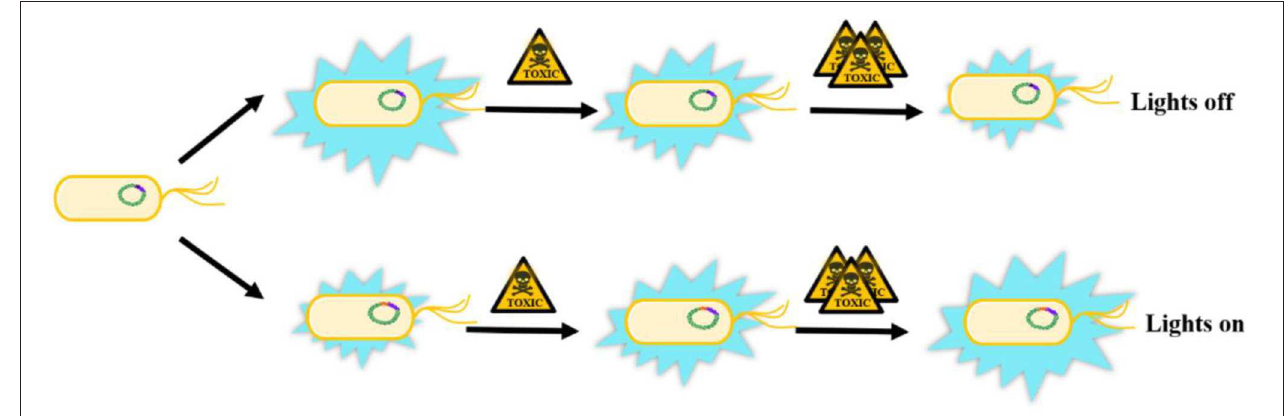
FIGURE 2 | The biosensor patterns in toxicity assessment based on recombinant luminescent bacteria. Lights off: the luminescence will be emitted continuously and decrease with the increasing quantity of toxic substances. Lights on: lux genes are fused with inducible promoters which could be transcribed and expressed under the expose of specific chemicals and the luminescence will increase with the increasing quantity of specific toxic chemicals. Chromosome, lux genes and promoters are presented with green, purple and orange color respectively.